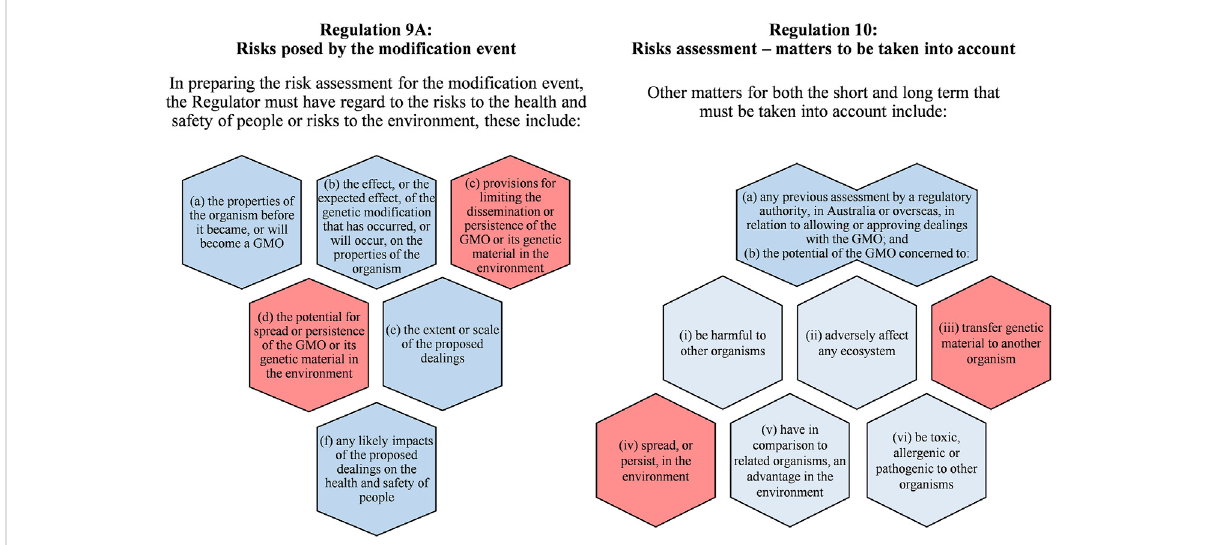
FIGURE 1 Summary of matters prescribed in the Australian Gene Technology Regulations 2001 that the Australian Gene Technology Regulator must consider in the risk assessment for a proposal to release a genetically modi fi ed (GM) organism, including a (GM) plant, into the environment (OGTR, 2020). Prescribed matters with a background shading of red may include consideration for horizontal gene